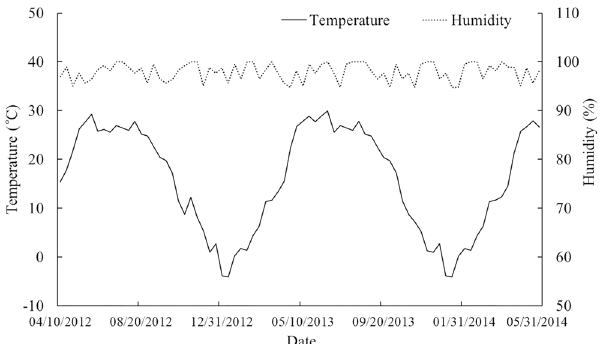
Fig 1. Fluctuation of mean dekad temperature and humidity in the soil during the